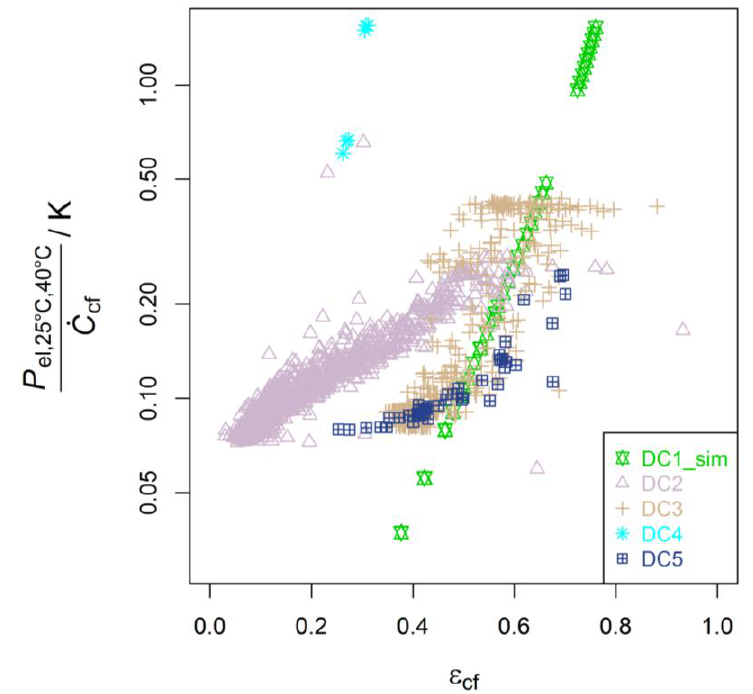
Figure 7. Electric power for pump at 40 °C ( 𝑃 capacity flow rate versus cooling effectiveness ( 𝜖 coolers (DC1 and DC4 in boundary B2 and DC2, DC3 and DC5 in B3; Excluding B1).